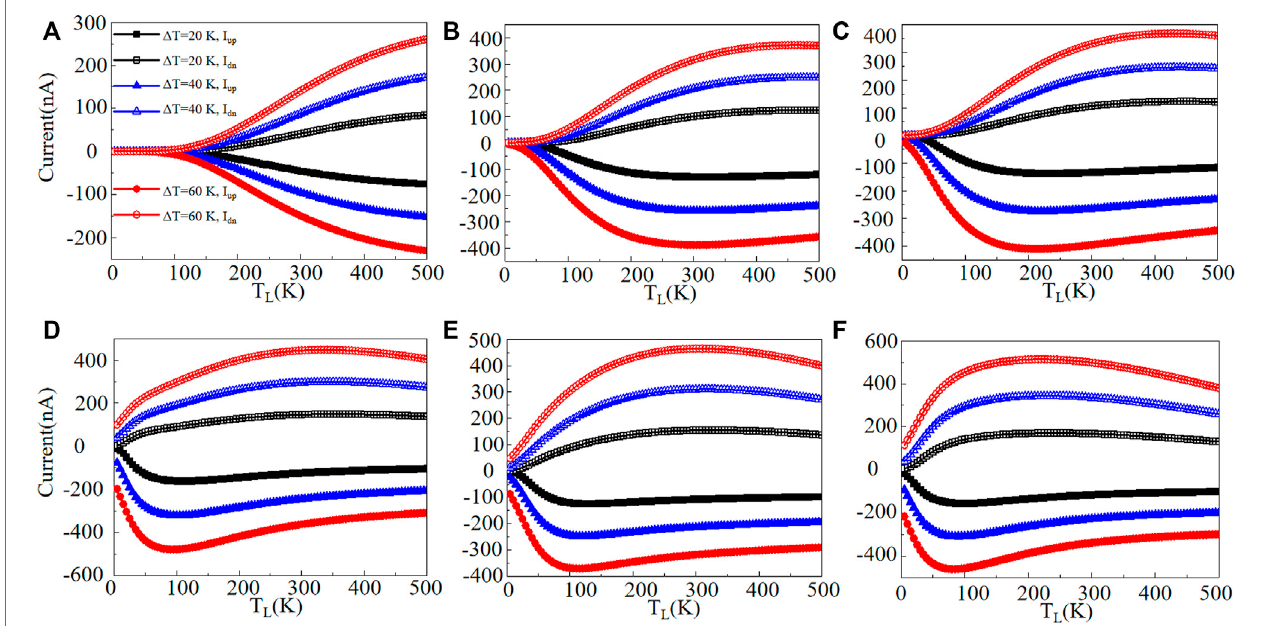
FIGURE4| Spin-up currents( I up ) andspin-down currents( I dn ) in termsof T L for theN-ZKGeNRs(N= 4 – 9)devicesatselected temperaturegradients, (A) N= 4, (B) N = 5, (C) N = 6, (D) N = 7, (E) N = 8, (F) N = 9.